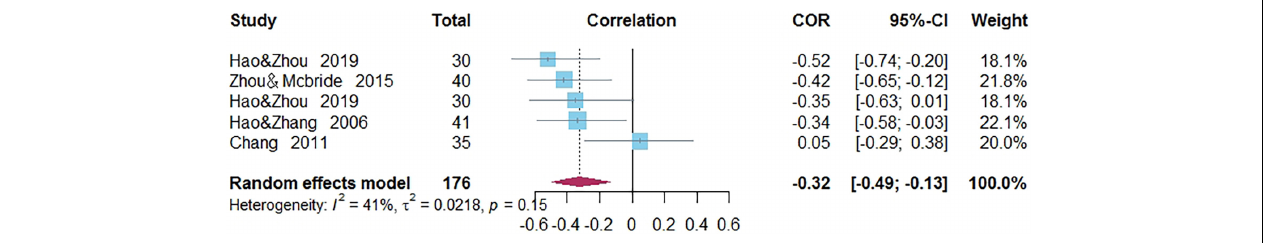
Frontiers in Psychology |